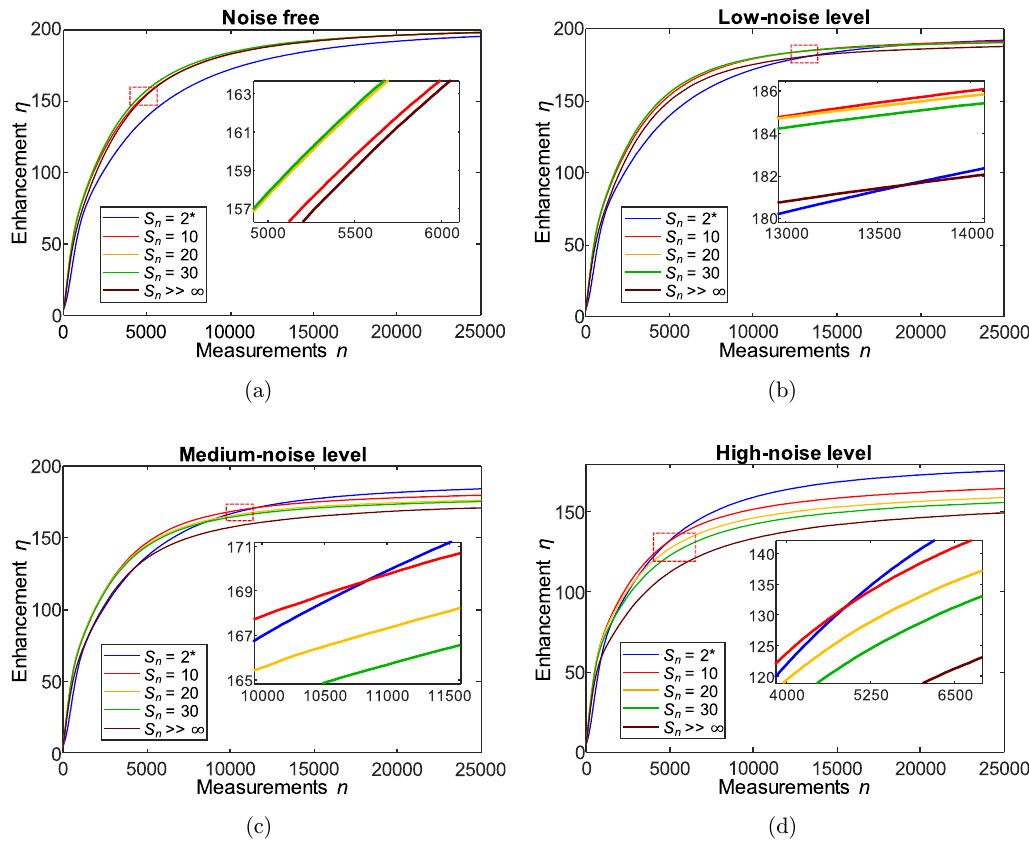
Fig. 3. Comparisons of di®erent schemes to select parents. S n = 2 is the one used in Ref. 18, which is marked with an asterisk. (a) – (d) The enhancement as a function of the number of measurements under di®erent conditions: noise free, low-noise level, medium-noise level, and high-noise level. Insets are provided for visualization